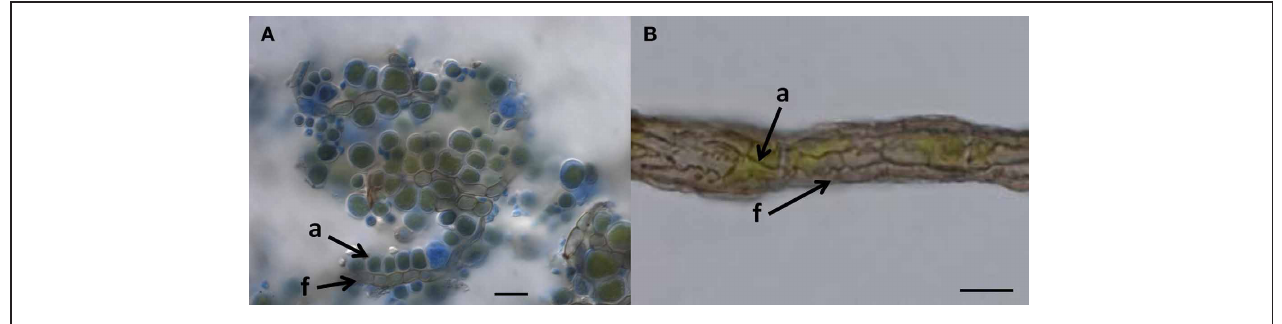
FIGURE 1 | When do we call it lichen? (A) Lichen-like association of Cladosporium -like fungus (according to ITS sequences) with aerial algal cells, on polypropylene surface, Botanical Garden Graz, 2011. Arrows indicate